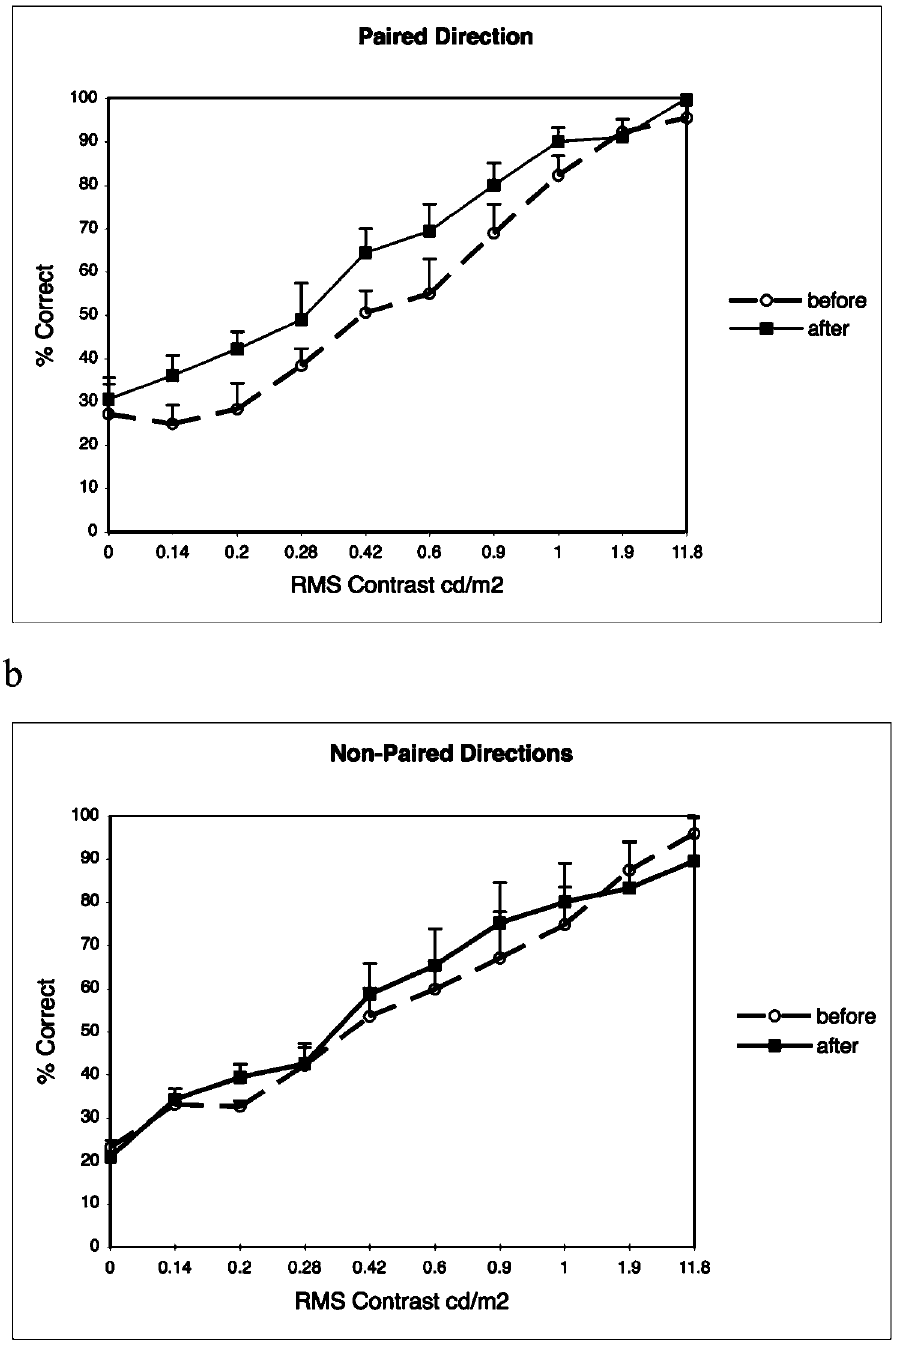
Figure 3. Motion-direction sensitivity change from Direction Training. a, performance for paired-direction on pre-test (dashed-line) and post-test (solid-line). b, performance for averaged across non-paired directions on pre-test (dashed-line) and post-test (solid-line). Error bars reflect standard- error.